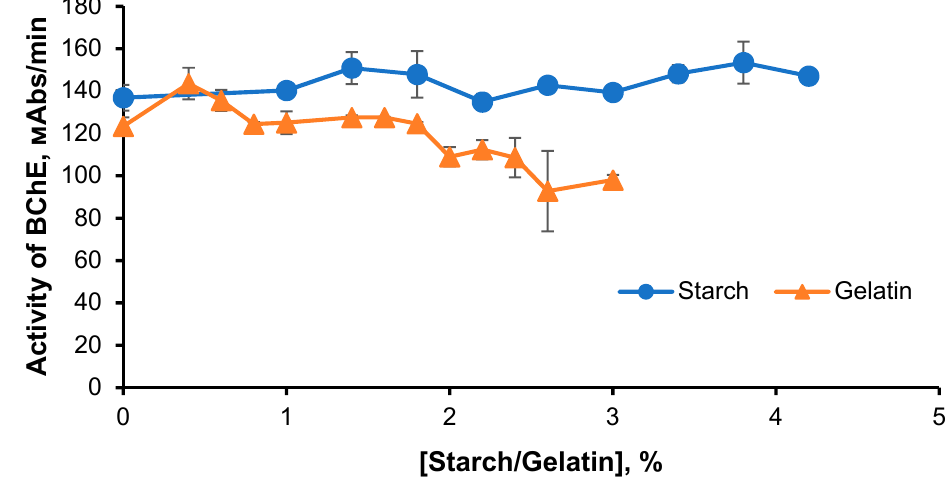
Figure 1. The rate of enzymatic hydrolysis of butyrylthiocholine iodide on the concentration of starch and gelatin.